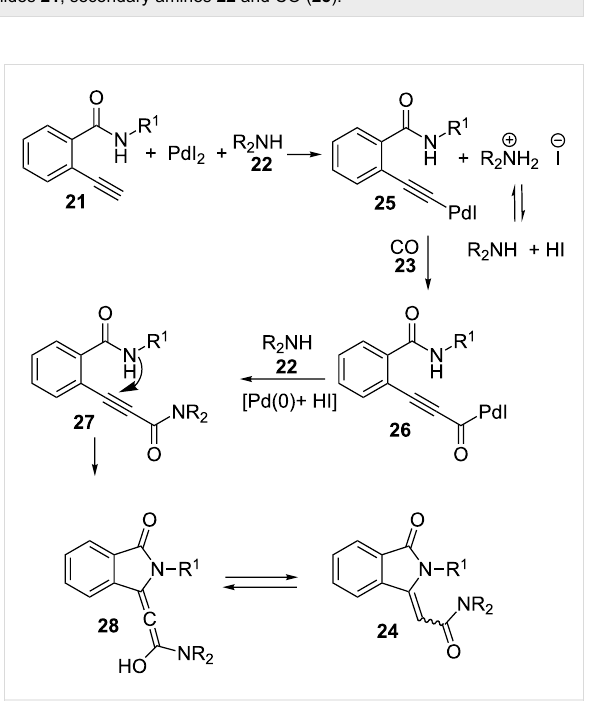
Scheme 6: Proposed mechanism for the formation of methyleneisoin- dolinones 24